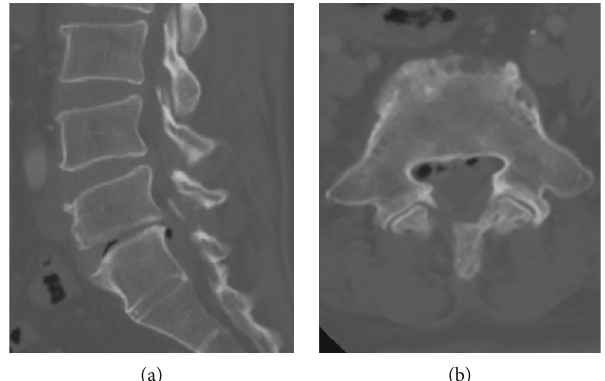
Figure 1: CT scan images revealing multiple gas bubbles at L5/S1 level as shown in axial (a) and sagittal (b) cuts.